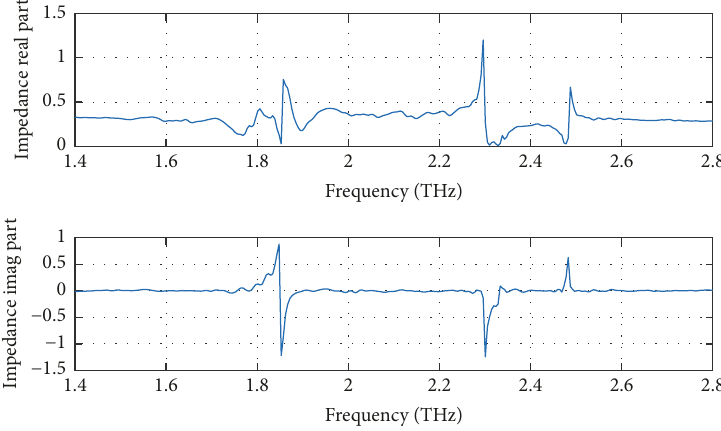
Figure 15: The normalized impedance calculated from the scattering